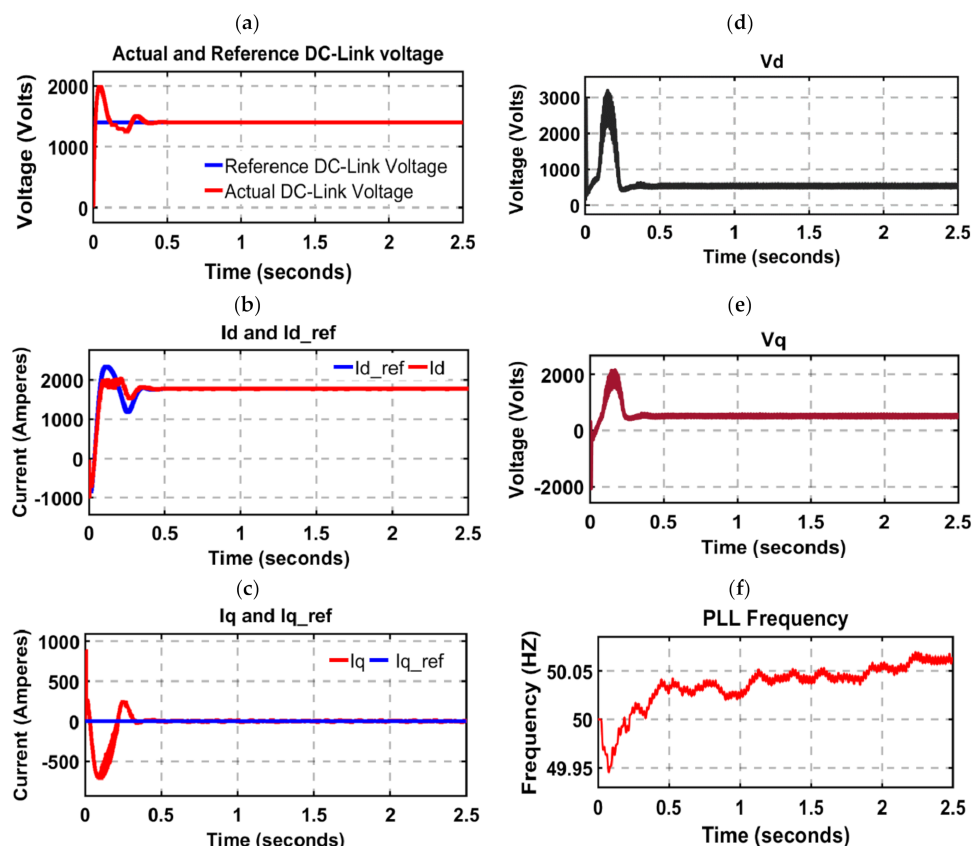
Figure 6. ( a ) Actual and Reference DC-link voltage, ( b ) Id and Id-ref, ( c ) Iq and Iq-ref, ( d ) Vd, ( e ) Vq, and ( f ) phase-locked loop (PLL)